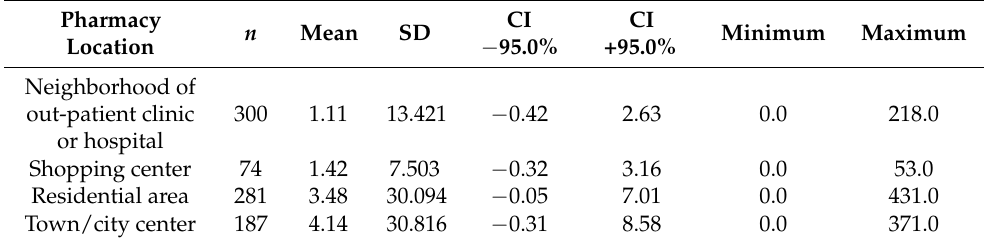
Table 3. Statistical analysis of the number of pharmaceutical prescriptions based on pharmacy